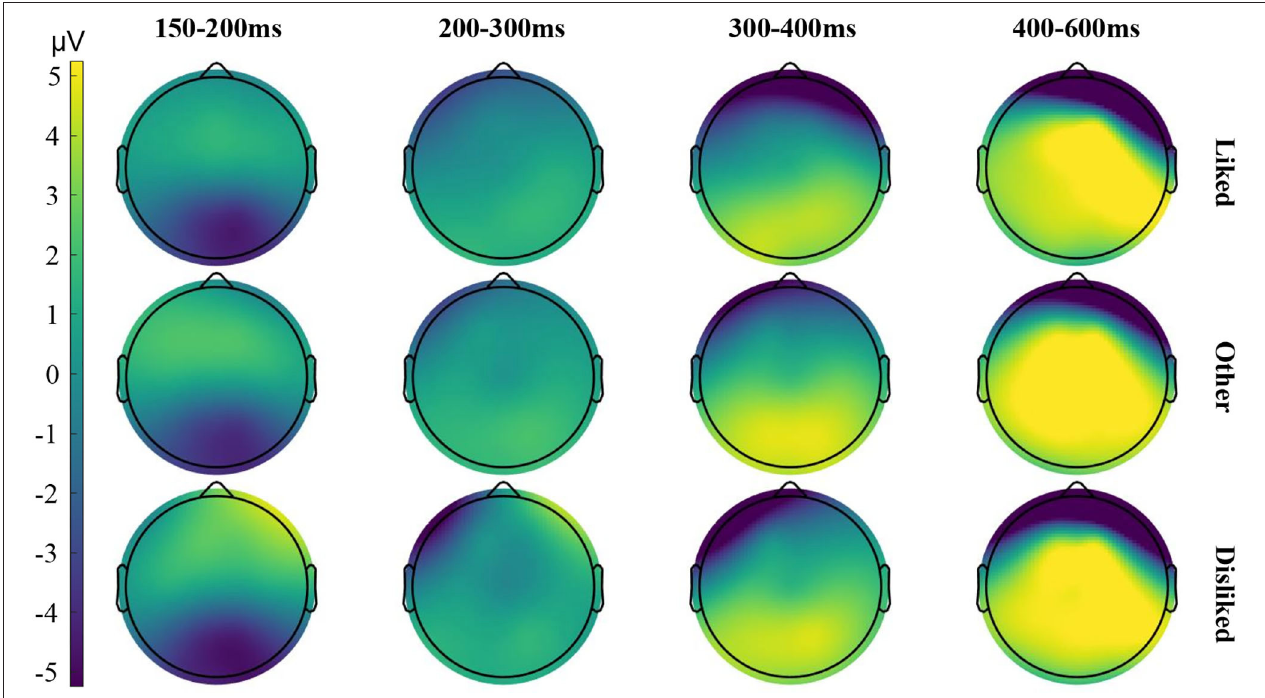
FIGURE 6 | Brain voltage maps for liked/disliked/other stimuli across different time window. The maps were constructed based on the grand average ERP waveforms recorded under each